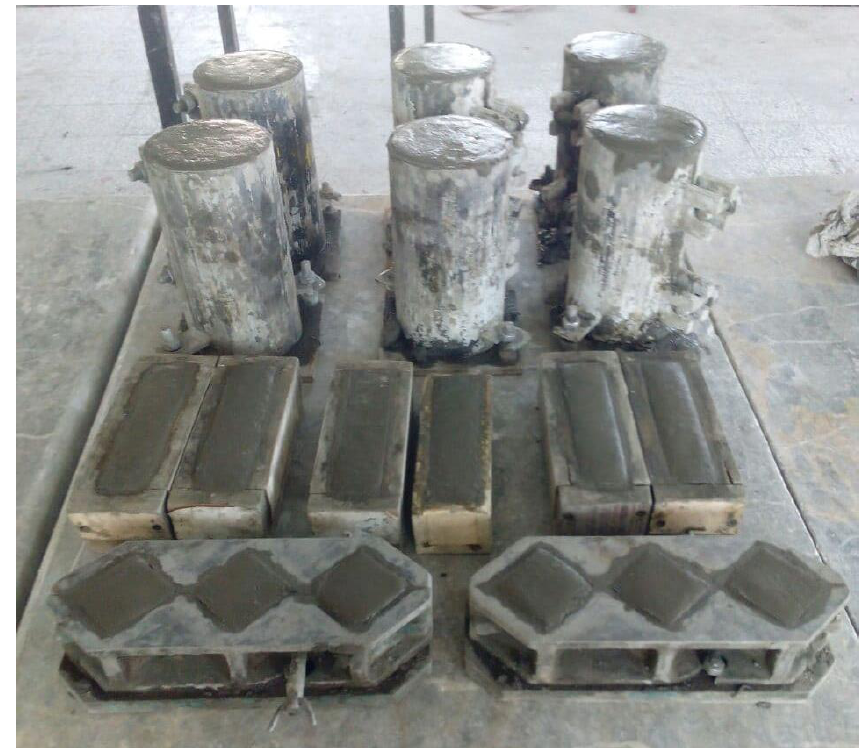
Figure 2. Molds after casting for tensile, flexural, and compressive strength tests from top downward, respectively.